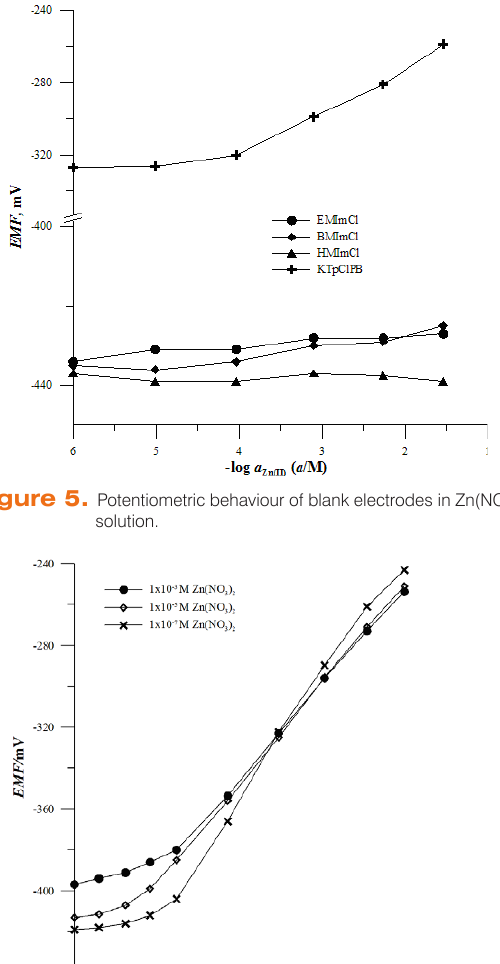
Figure 6. Effect of zinc concentration in conditioning solution on response of electrode based on BMImCl and